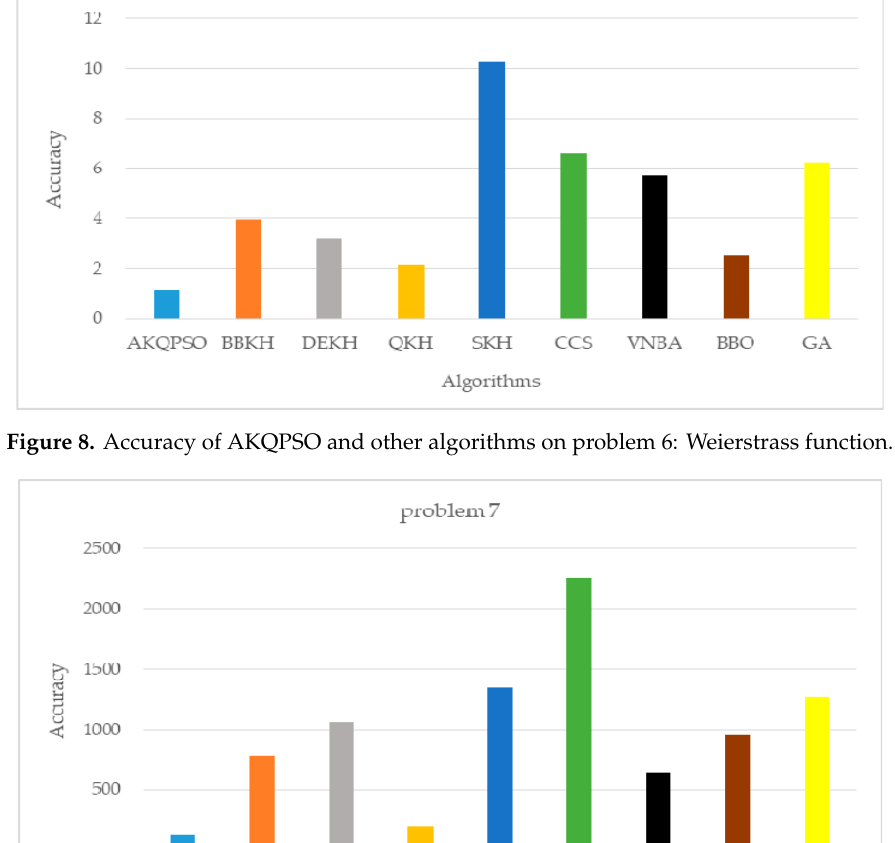
Figure 7. Accuracy of AKQPSO and other algorithms on problem 5: Griewangk’s function.